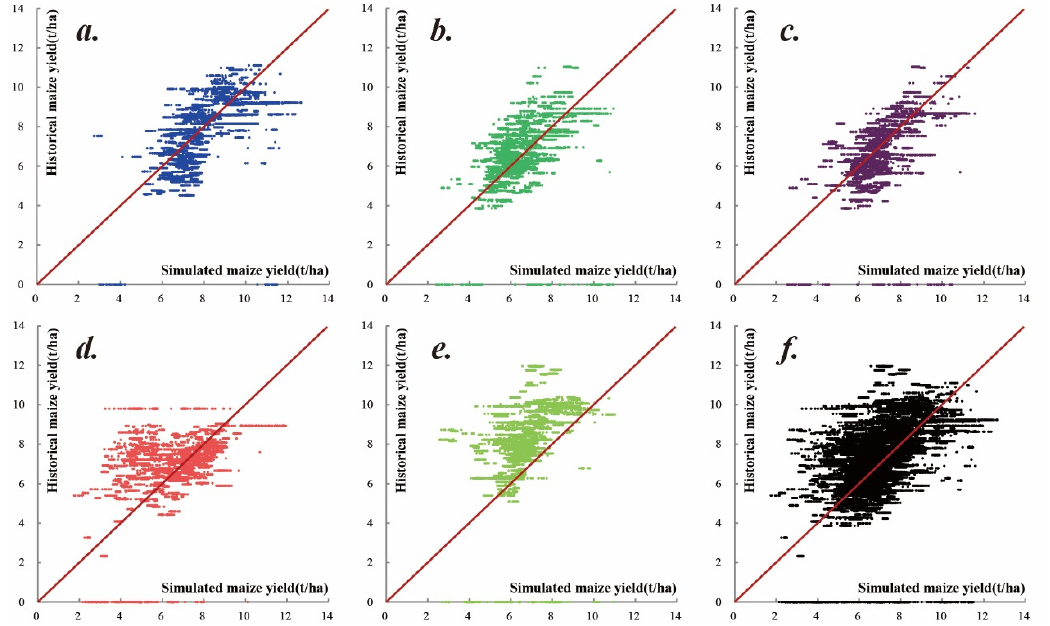
Figure 4. Correspondence between simulated and historical maize yield from years 2000 to 2004. Correspondence in 2000 ( a ); correspondence in 2001 ( b ); correspondence in 2002 ( c ); correspondence in 2003 ( d ); correspondence in 2004 ( e ); correspondence from 2000 to 2004 ( f ).